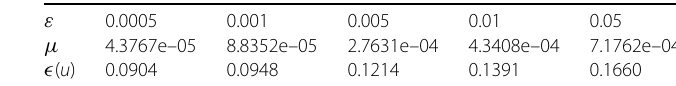
Table 1 At t = 0: α = 1.5, θ = 0, s = 2, γ = 0.2, the relative errors for various ε